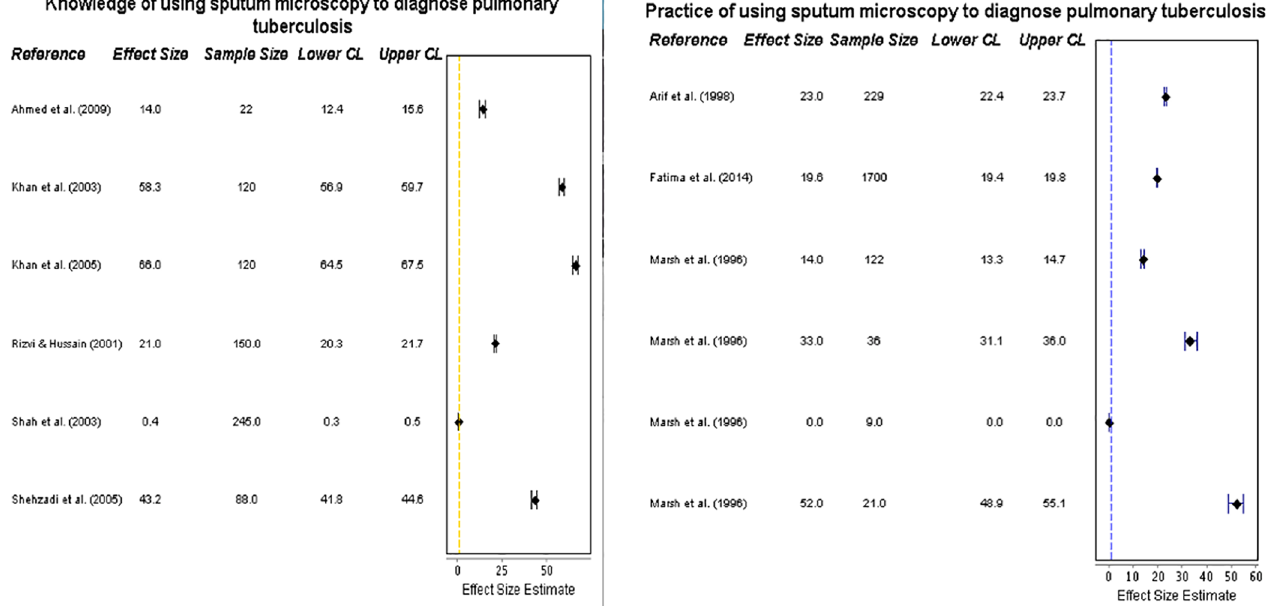
Fig 3. Forest plots on diagnosis knowledge and practice. (a) Forest plot visualising data on practitioners’ knowledge of using sputum microscopy for the diagnosis of pulmonary tuberculosis (ISTC Standard 2). CL = 95% Confidence Level. (b) Forest plot visualising data on practitioners’ practice of using sputum microscopy for the diagnosis of pulmonary tuberculosis (ISTC Standard 2). Marsh et al. (1996) includes 4 sets of data for this ISTC Standard, reflecting 4 different practitioner groups. CL = 95% Confidence Level.